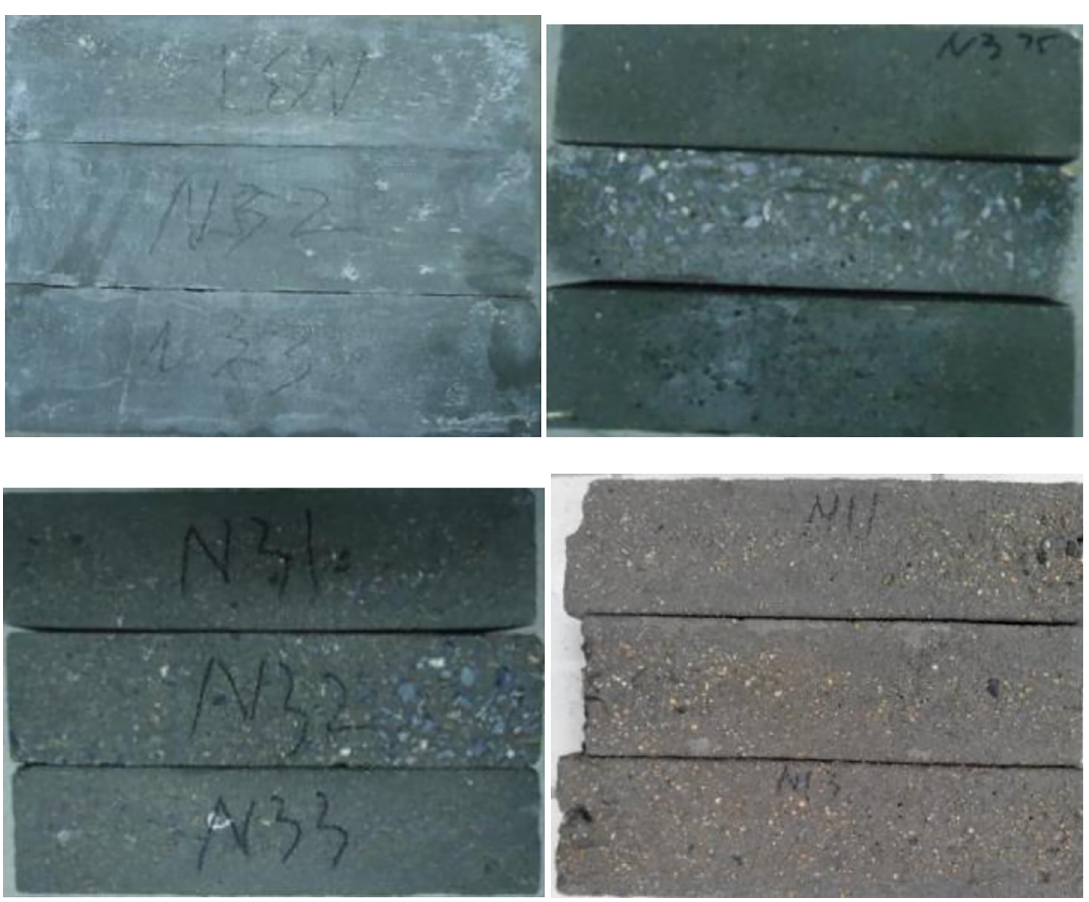
Fig 9. Surface description of plain concrete exposed to different freeze-thaw